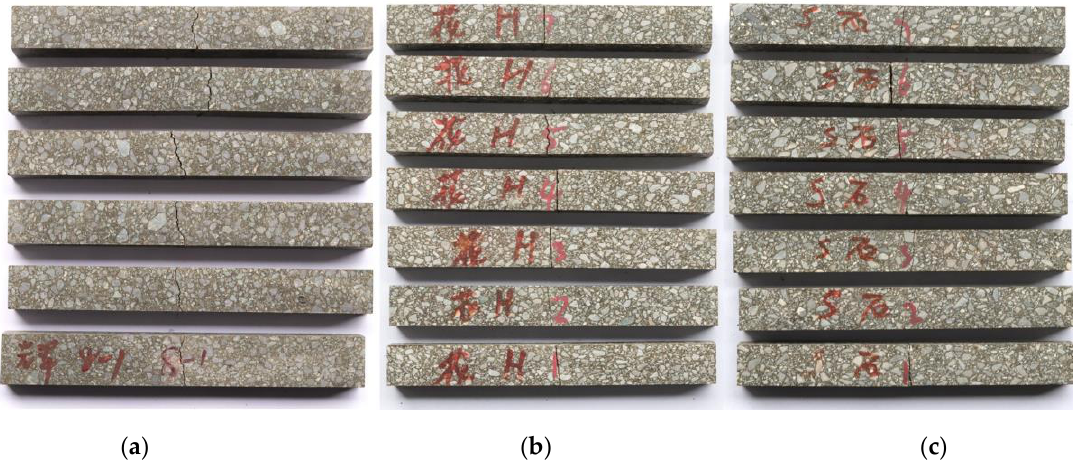
Figure 5. Three types of EAC beam specimens: ( a ) diabase, ( b ) granite, and ( c ) limestone.